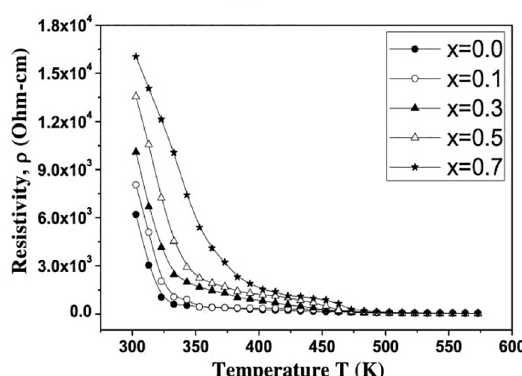
Figure 3. Temperature dependence resistivity of Cu-Zn ferrites.